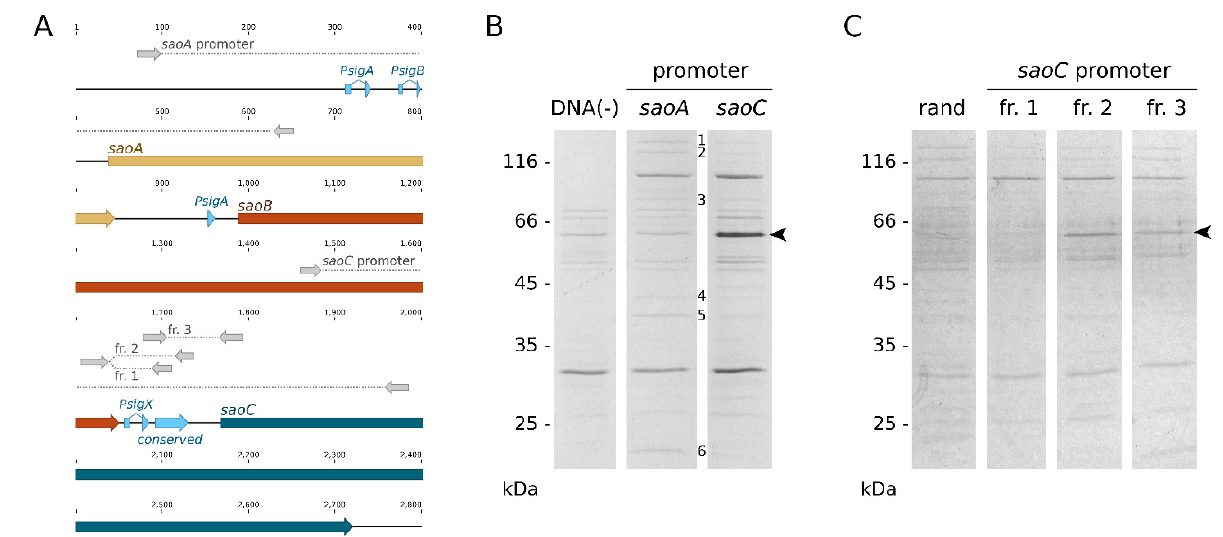
Figure 3. SaoC binds within the uncharacterised conserved motif upstream of its own gene. ( A ) The scheme showing which fragments of saoABC operon were used in the experiment and which con- served motifs they encompassed. Next to two major regions covering vast extents of putative promoter regions of saoA and saoC , three shorter fragments of the latter were used to narrow down the region bound by SaoC. ( B ) SDS-PAGE of protein samples from DNA pull-down assays performed on the two major putative promoter regions of saoA and saoC and whole-cell S. aureus lysates. When compared to the control without DNA, the major fragment of saoC promoter is bound by SaoC pro- tein as confirmed by mass spectrometry. In the case of the saoA promoter region, no evident binding is detectable in applied conditions. The identity of a few differentiating bands (1–5) points at general DNA-binding proteins or their fragments (1, single-stranded DNA-binding protein; 2, 3 ′ –5 ′ exori- bonuclease YhaM; 3, type I DNA topoisomerase; 4, DNA polymerase I; 5, RNAP β ’ subunit; 6, RNAP β subunit). ( C ) SDS-PAGE of protein samples from DNA pull-down assays performed correspond- ingly on the three shorter fragments of the putative saoC promoter region. Only the fragments con- taining the uncharacterised conserved region are bound by SaoC. The control used here was a ran- domly shuffled fragment of the saoC putative promoter sequence. Expression of saoABC genes is elevated in stress conditions . Revealing the presence of σ B promoter upstream of the whole saoABC operon suggested its participation in the stress response. In order to confirm that suspicion we tested the expression of all three operon genes in S. aureus in different stress conditions: acidification, antibiotic exposure, depletion of the amino acid source or the preferential source of carbon, heat stress, osmotic stress, oxidative stress and salinisation. Among all these conditions we observed changes of the expression pattern of saoABC genes only in the case of acidification, depletion of the amino acid source or the preferential source of carbon (Figure 4). The expression of saoA is particularly elevated by acidification and depletion of the preferential carbon source, whilst depletion of the amino acid source alters, in a similar manner, the expression of